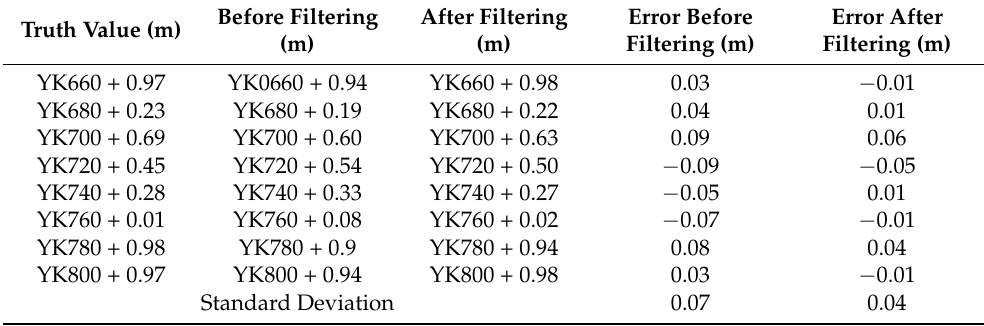
Table 1. Mileage positioning accuracy.